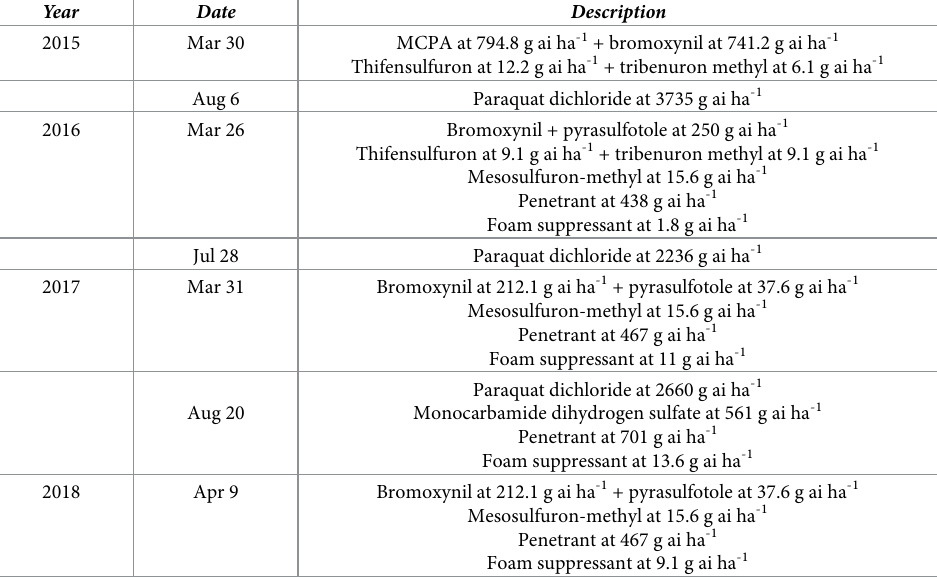
Table 1. Herbicide applications in the winter wheat